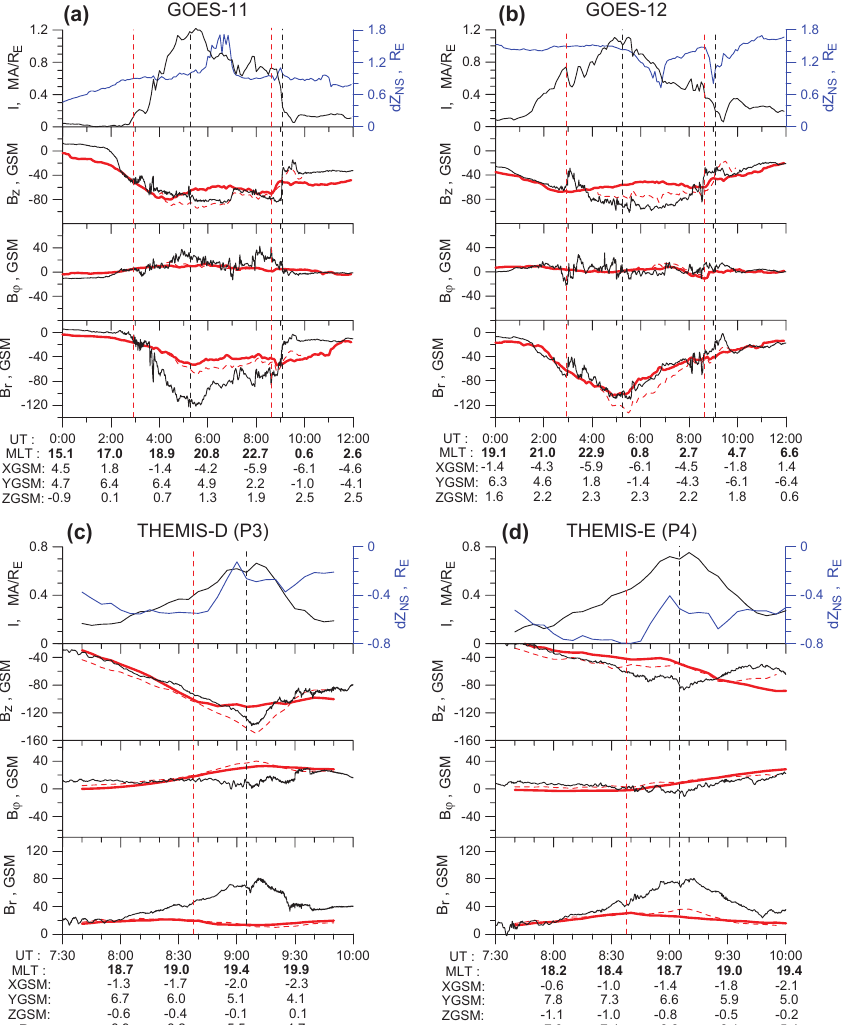
Fig. 3. (a) – (d) Observations of four spacecraft. Top panel: the estimate of the total current I = 2 B r /µ 0 in units of MA/R E (black curve) and distance to the model neutral sheet (blue curve). The next three panels show the B z , B ϕ , and B r components (dipole field subtracted) in nT: black – spacecraft observations; red solid curve – TS05 model field; red dashed curve – TS05MOD field. Red and black vertical lines mark beginnings of rapid AL intensifications and Sym-H ∗ minima,